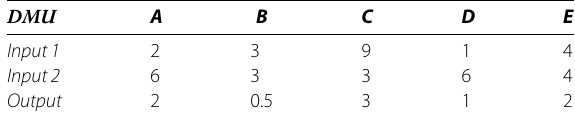
Table 1 DMUs with two inputs and a single